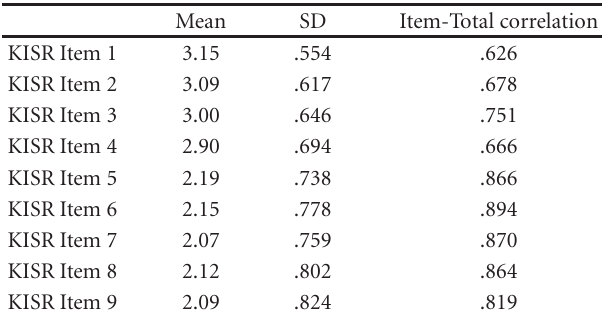
Table 1: KISR item means, standard deviations, and correlations with total ( n =